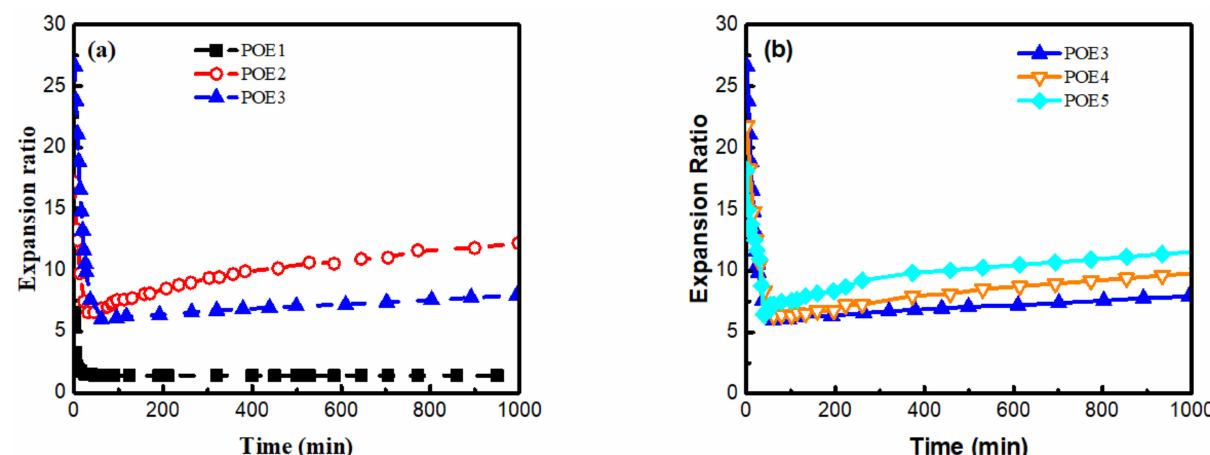
Figure 16. Shrinkage recovery behavior of POE foams with higher expansion ratio. ( a ) POE samples with same MI; ( b ) POE samples with same octene content.